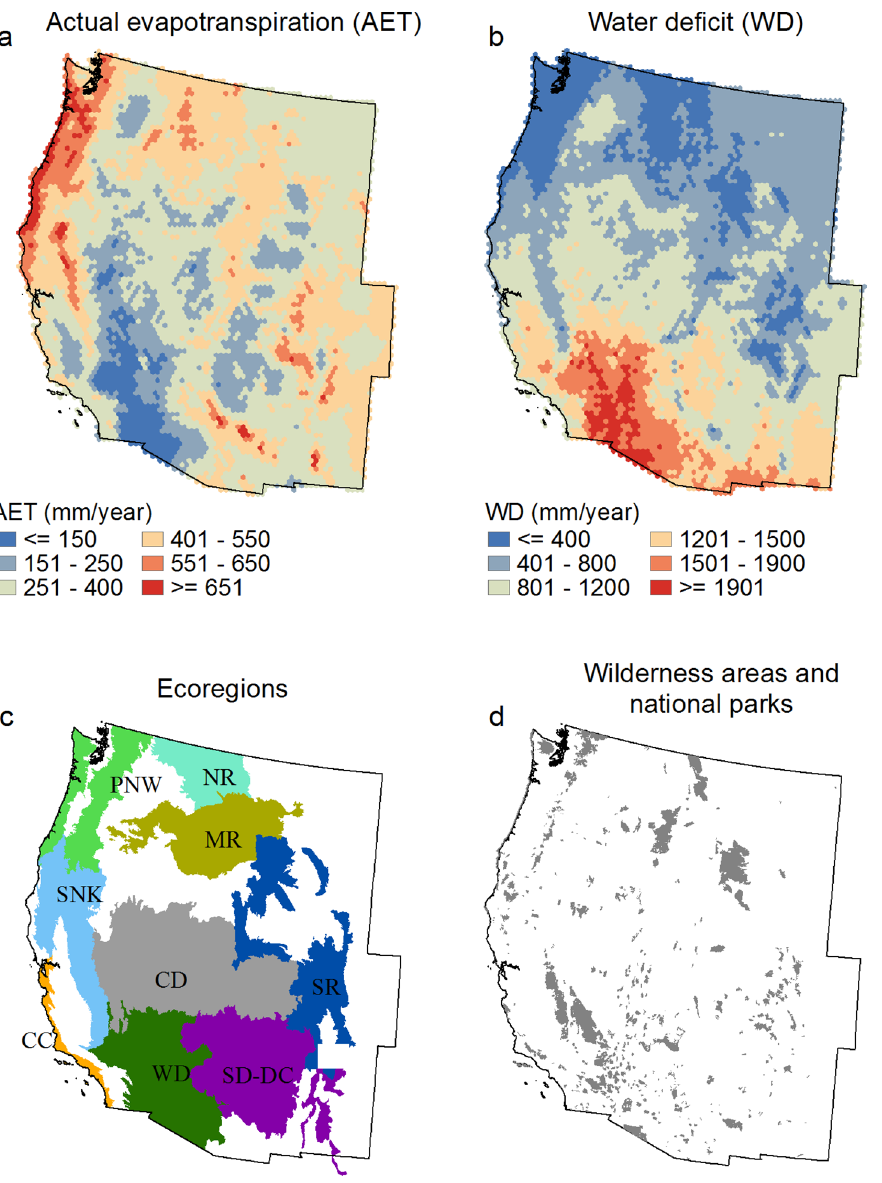
Figure 1. Mean actual evapotranspiration (AET) (a) and water deficit (WD) (b) per 50,000 ha hexel for the western US from 1984– 2010. Also shown are the ecoregions (USDA Forest Service, 2007) we analyzed (c): California chaparral (CC), cold desert (CD), middle Rocky Mountains (MR), northern Rocky Mountains (NR), Pacific Northwest (PNW), semi desert – dry conifer (SD-DC), Sierra Nevada and Klamath (SNK), southern Rocky Mountains (SR), warm desert (WD). Cold desert and semi desert – dry conifer are both the result of merging two ecoregions; all ecoregions were renamed for easier interpretation. Areas in white represent ecoregions that did not contain enough fire and/or wilderness and national park area to be included in this study (see Methods). Locations of wilderness areas and national parks in the western US